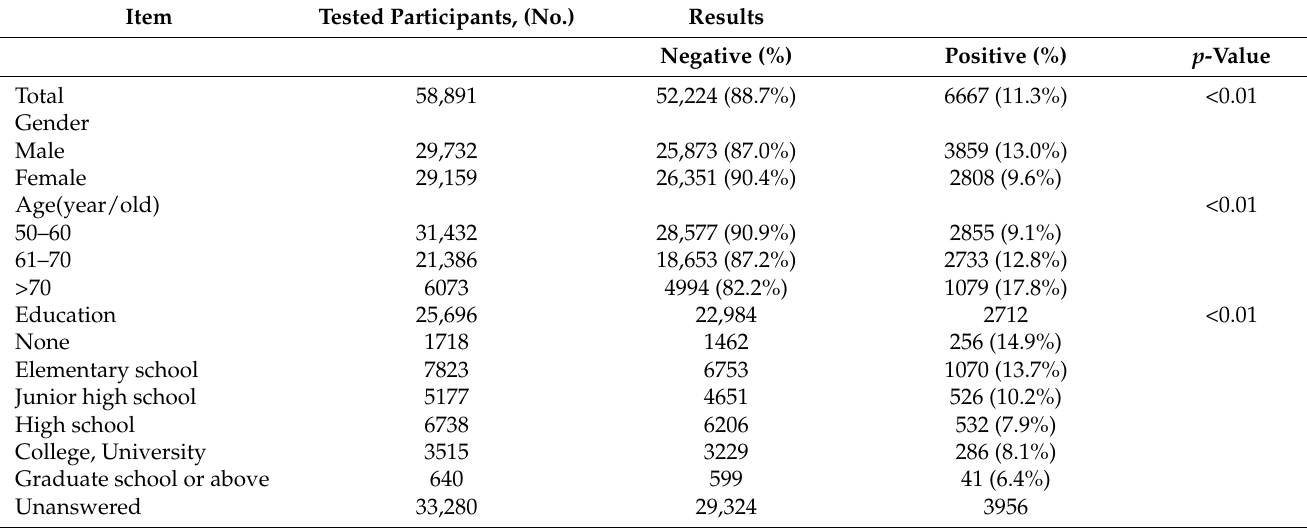
Table 2. Statistical analysis of basic information of participants and FOBT screening